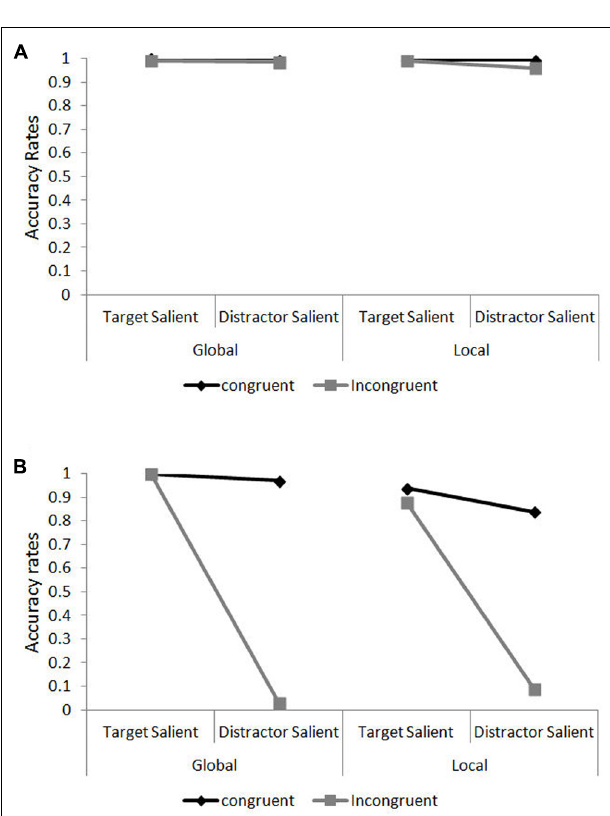
FIGURE 4 |Accuracy rates in the global/local task as a function of target level and target/distractor saliency. (A) Accuracy rates for the control patients in the compound letter task. (B) Accuracy rates for patient JM in the compound letter